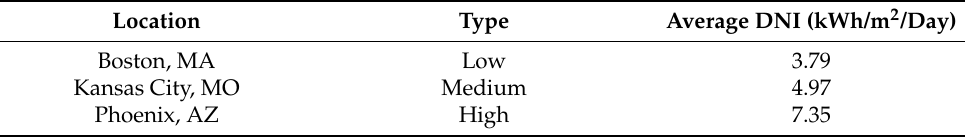
Table 1. Selected geographic locations and their respective DNI levels [29].